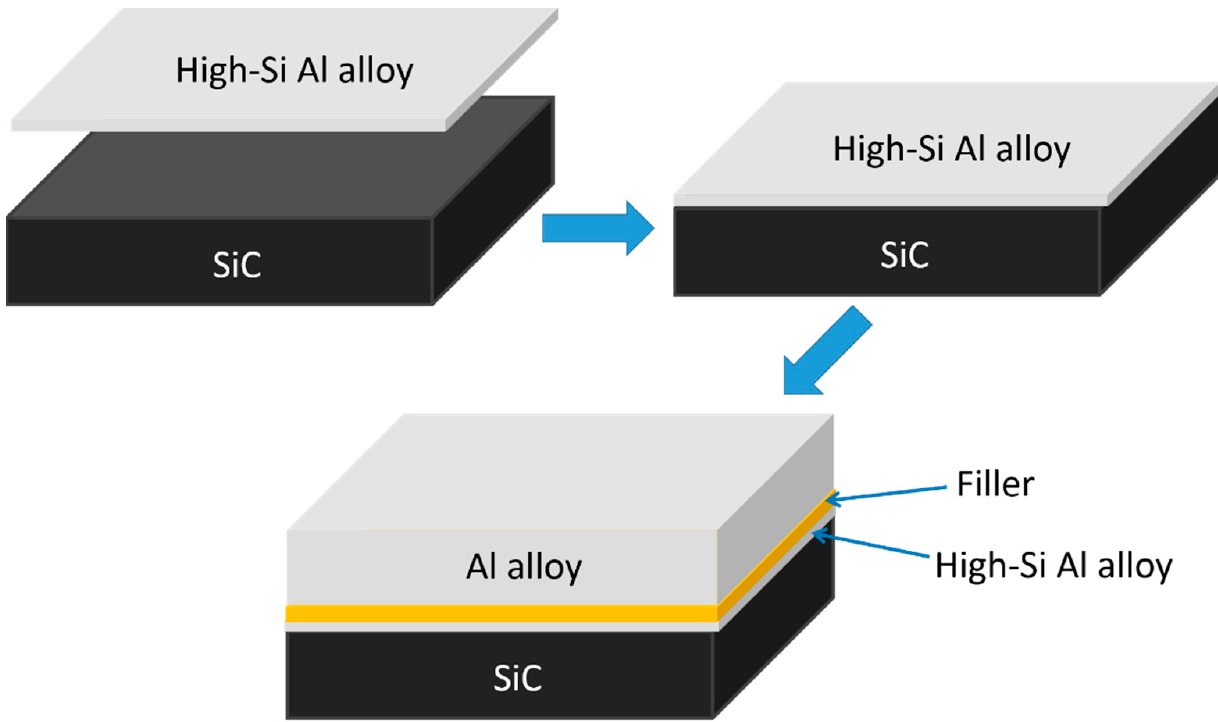
Figure 7. Illustration of the strategy for joining between SiC and a wide range of Al alloys through use of high-Si Al alloys.